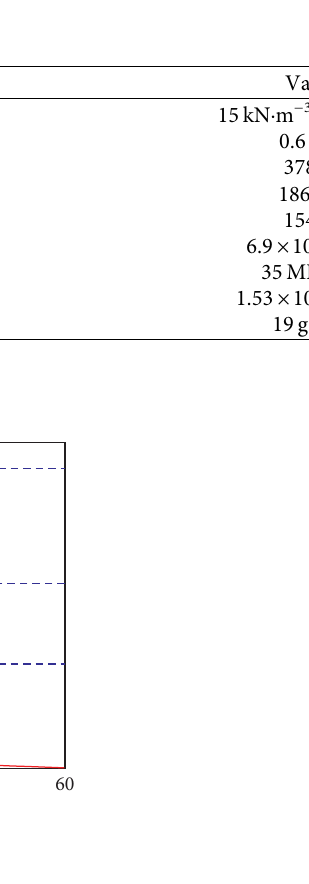
Figure 7: The predicted segment uplift of the tunnel with the proposed model.